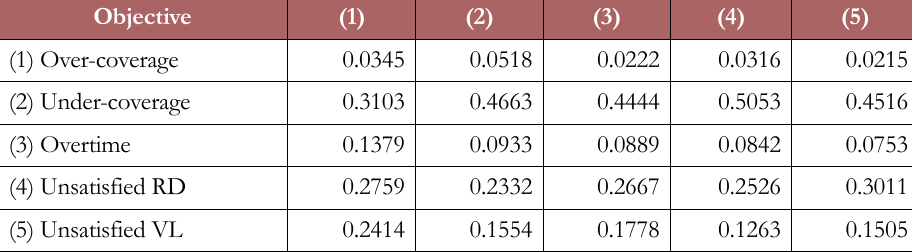
Table 8 . Normalized pairwise comparison